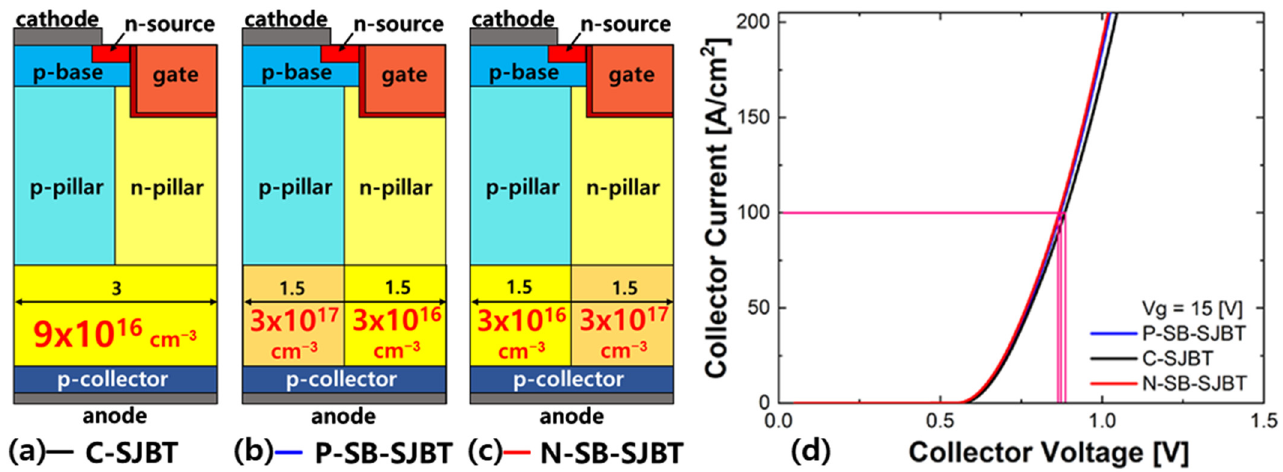
Figure 4. ( a ) C-SJBT in which the buffer is uniformly doped, ( b ) P-SB-SJBT in which the buffer below the p-pillar side is doped higher than the buffer below the n-pillar side and ( c ) N-SB-SJBT in which the concentration of each buffer is switched in the structure of P-SB-SJBT. ( d ) On-state I c - V c characteristic curves of C-SJBT, P-SB-SJBT, and N-SB-SJBT. ( V g = 15 V).